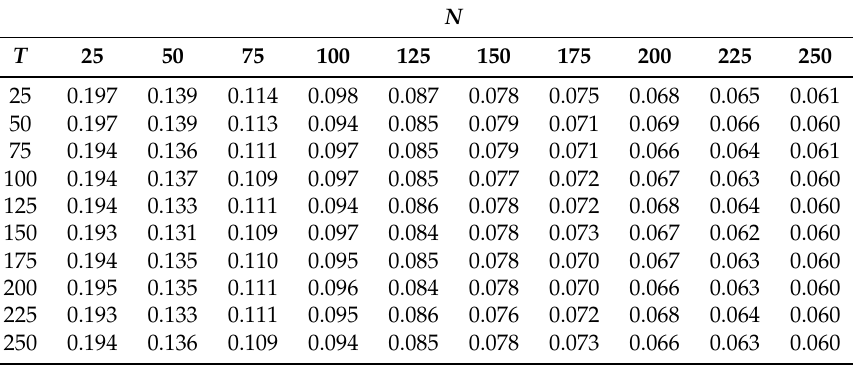
Table 2. Standard error of the ergodicity value of the factor with dominant variance between participants for different sample sizes and time series lengths. High values indicate uncertain measurements, while lower values indicate a more precise measurement of the degree of ergodicity in the